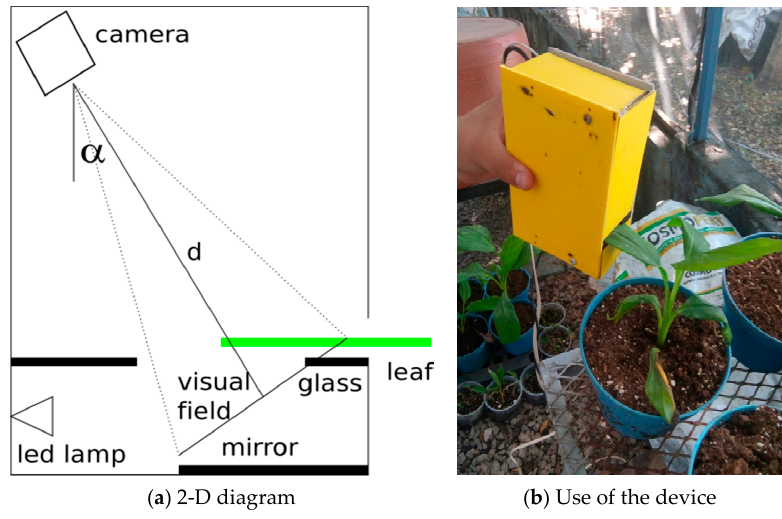
Figure 1. Optical system for the image acquisition: ( a ) Schematic view, ( b ) optical system test.